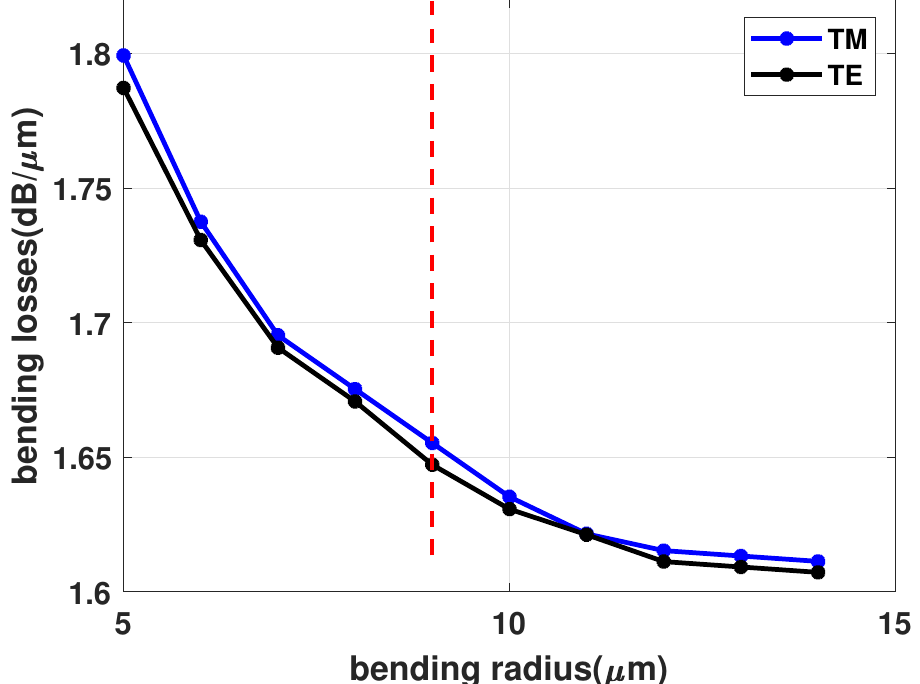
Figure 6. Bending losses vary as function of bending radius from 5 to 14 µ m modes were determined considering a central wavelength of 1581.5